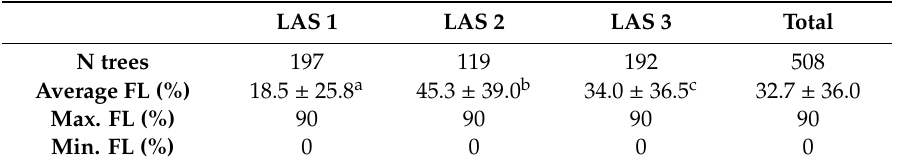
Table 3. Number of trees (N trees) and mean percentage fruit load (FL) of each LAS plot. Values followed by different letters indicate significant differences among LAS plots. (Kruskal – Wallis test: p < 0.05). LAS 1